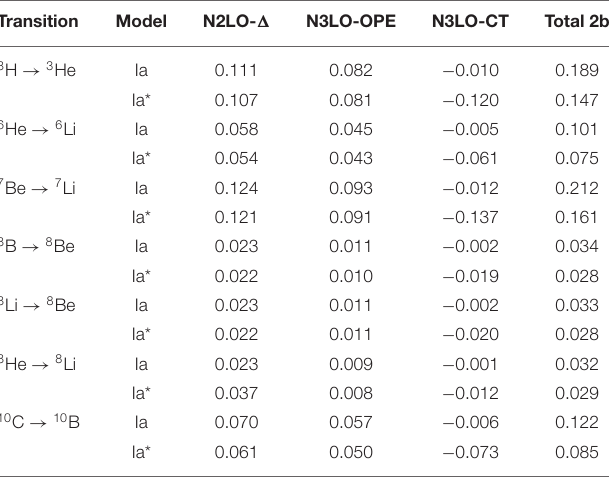
TABLE 3 | The scaling factors ( r 2 ij ρ 2b ) max used to normalize the N2LO- 1 , N3LO-OPE, N3LO-CT, and total two-body transition densities in Figure 5 . Transition Model N2LO- 1 N3LO-OPE